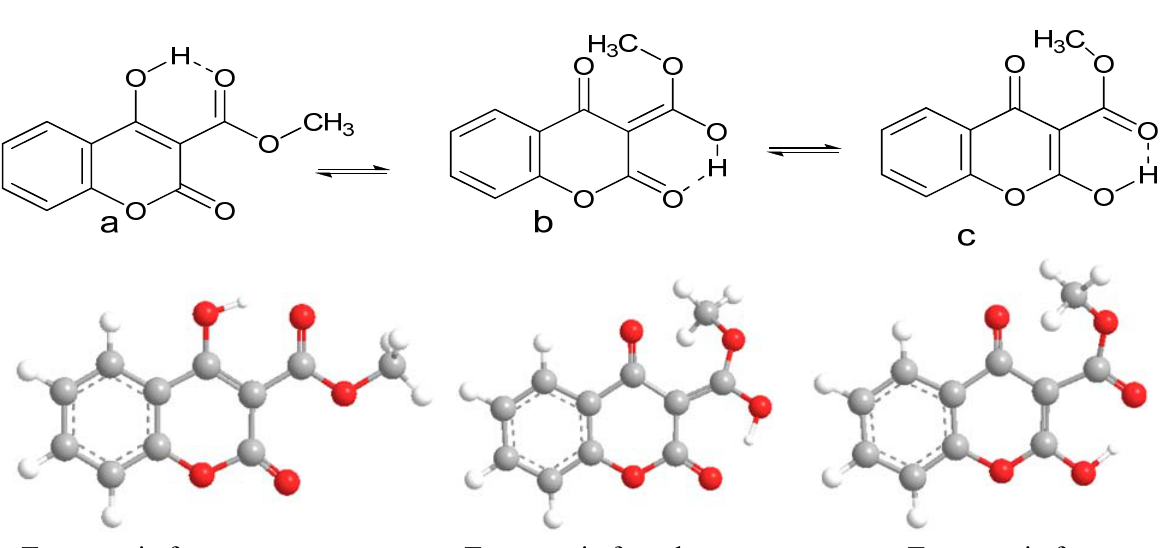
Figure 6. Optimized structures for the tautomers of 3-methoxycarbonyl-4-hydroxy coumarin using DFT.